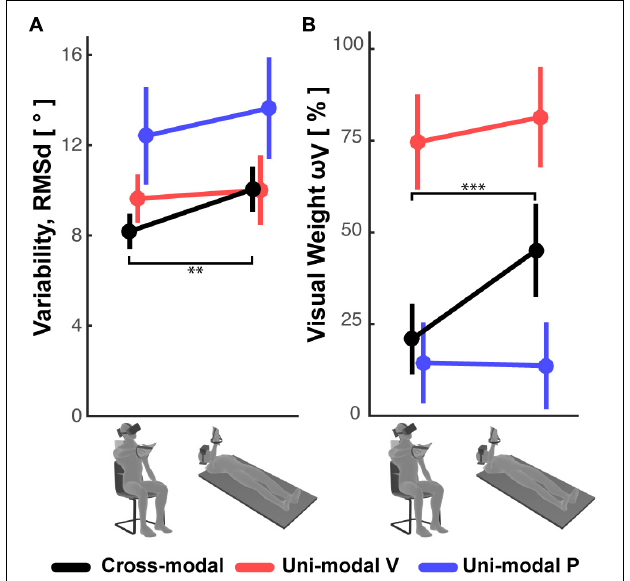
FIGURE 5 | (A) Subjects’ response variability and (B) visual weight observed in the Seated and Supine conditions for the cross-modal and the two uni-modal (visual and proprioceptive) experiments. Vertical whiskers correspond to 95% confidence intervals. ∗∗ and ∗∗∗ represent p < 0.01/3 and p < 0.001/3, respectively, and their color represents the experiment to which they refer.